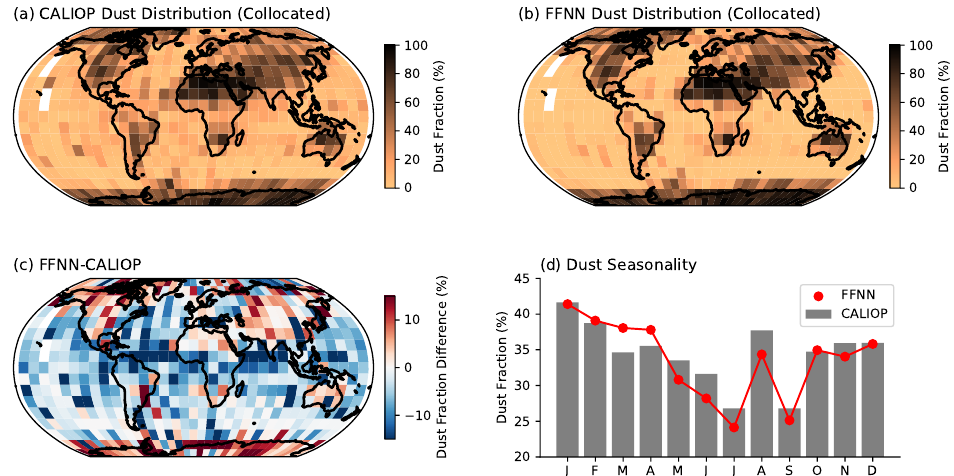
Figure 4. ( a , b ) Spatial dust distribution for all test days. ( a ) CALIOP and ( b ) FFNN shows the dust distribution over CALIOP and VIIRS collocated track. Dust distribution is plotted with 5 × 5 lat-lon grid; ( c ) spatial difference between FFNN and CALIOP dust fraction; ( d ) monthly time series of CALIOP and FFNN dust fraction over the entire globe to show the